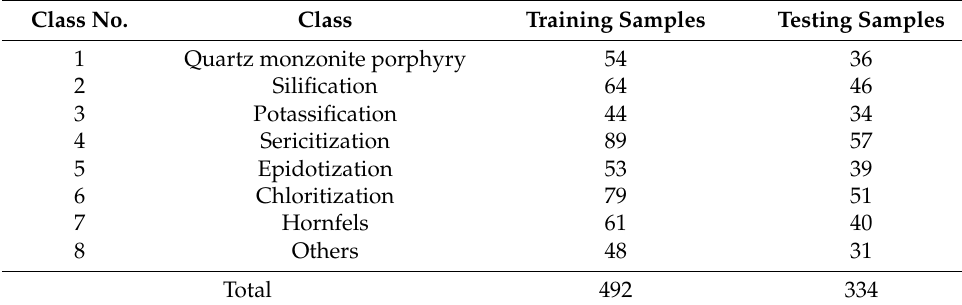
Table 4. The number of labeled samples on the measured hyperspectral dataset. Class No.